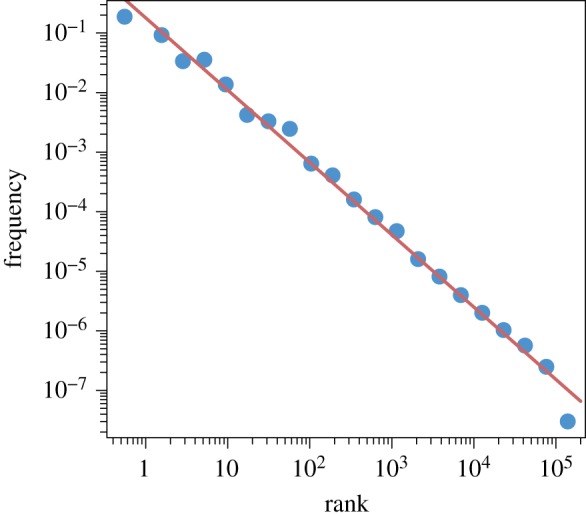
The data of figure 5 exponentially binned and with proteins with less than 500 amino acids (the unimodal peak) removed. A power law has been optimally fitted.